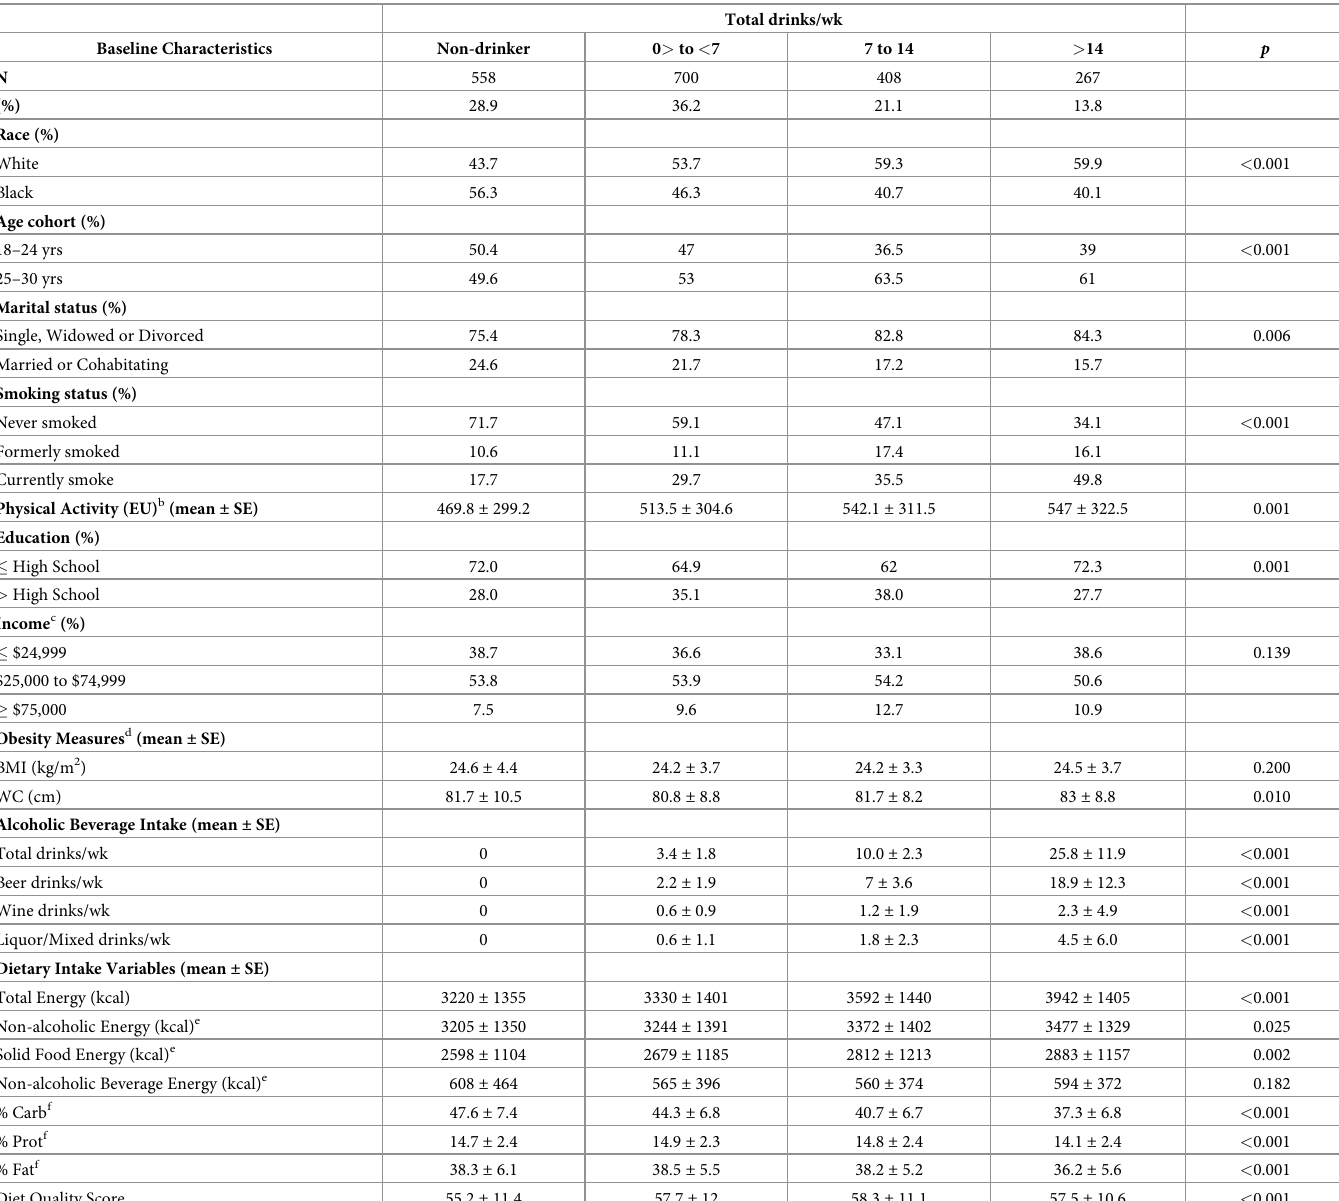
Table 1. Baseline characteristics of men in the CARDIA study 1985–1986, according to baseline alcoholic beverage intake (total drinks/wk) a .